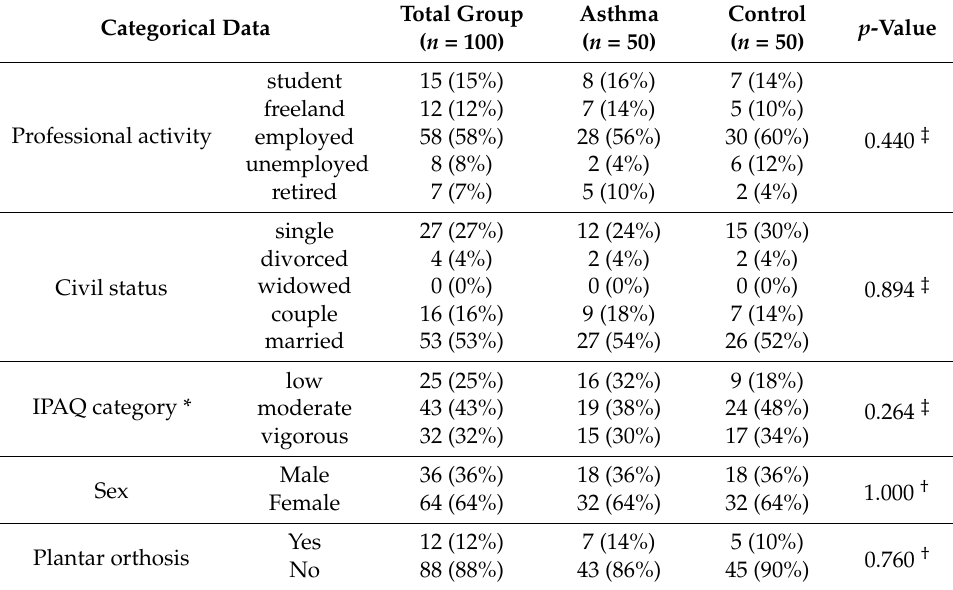
Table 2. Categorical sociodemographic and descriptive data for patients diagnosed with asthma, healthy matched-paired controls and total